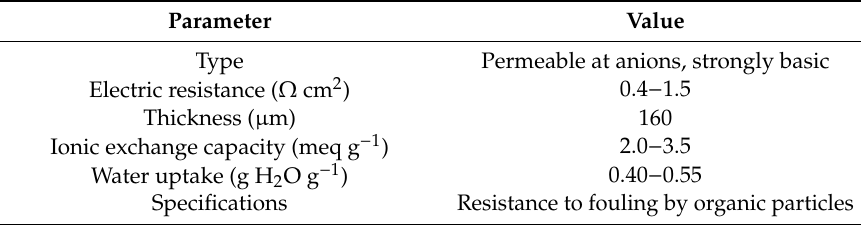
Table 1. Some characteristics of the commercial anion exchange membrane AFN